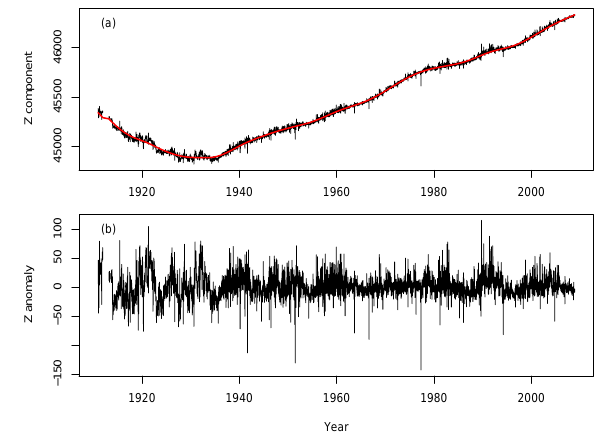
Fig. 2. (a) Daily variations of the Z component of the geomagnetic field measure at Eskdalemuir between 1911 and 2008. The red line represents the smoothed data with a spline function with 20 degrees of freedom. (b) Anomaly of the Z component with respect to the spline smoothing